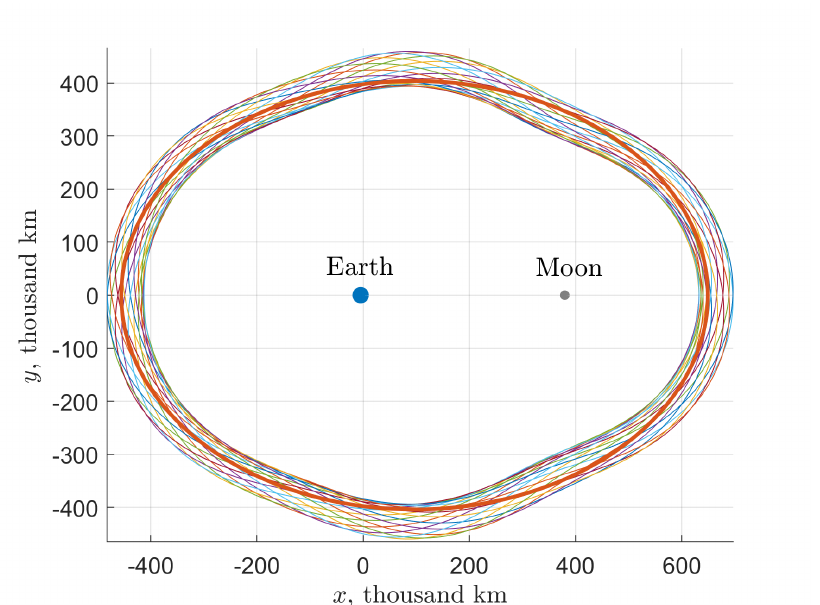
Figure 3. Earth–Moon region of prevalence boundaries for different Sun phase angles and the elliptical boundary of the mean-square averaged region of prevalence (bold